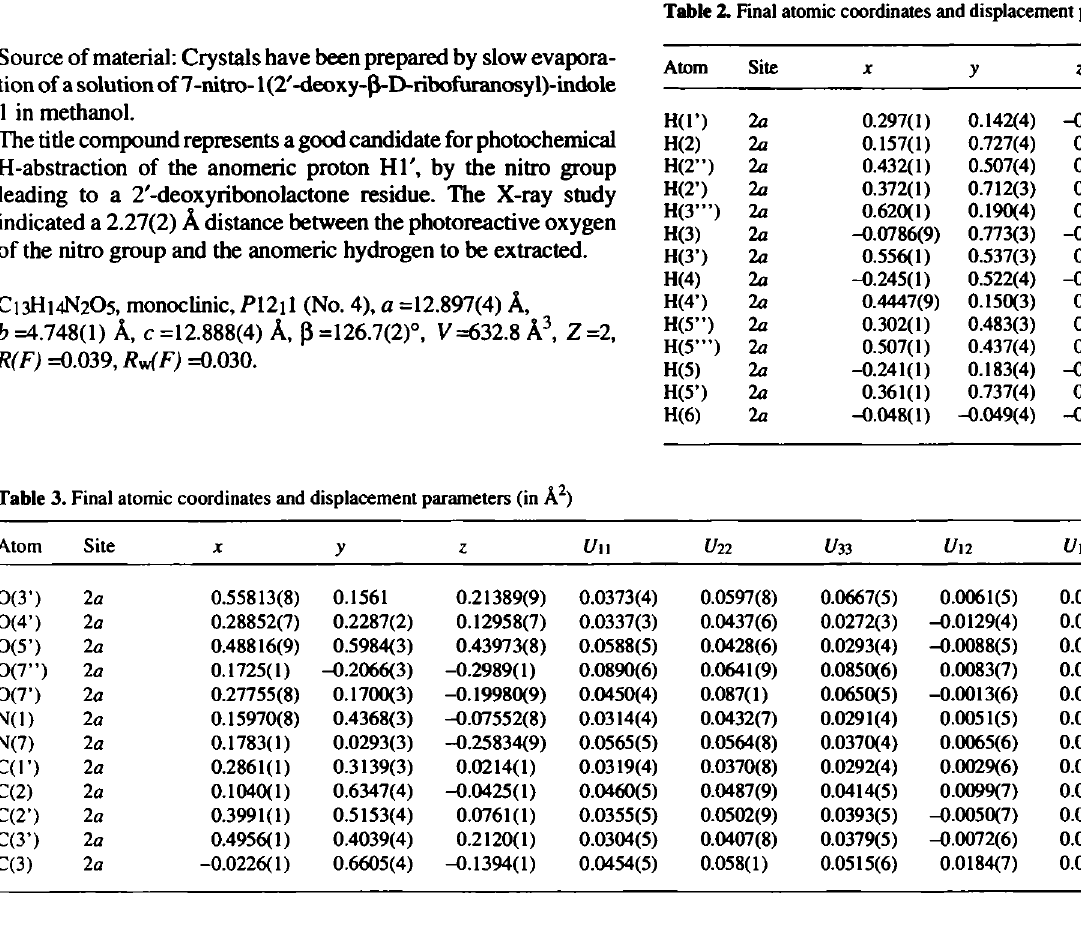
Table 2. Final atomic coordinates and displacement parameters (in Â^)